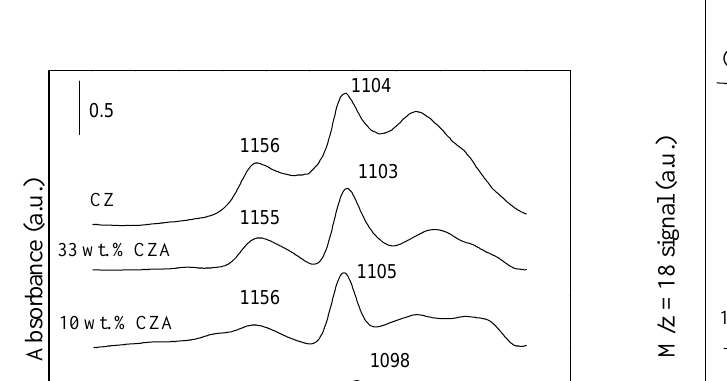
Zr O (  111 zone 0.67 0.33 2